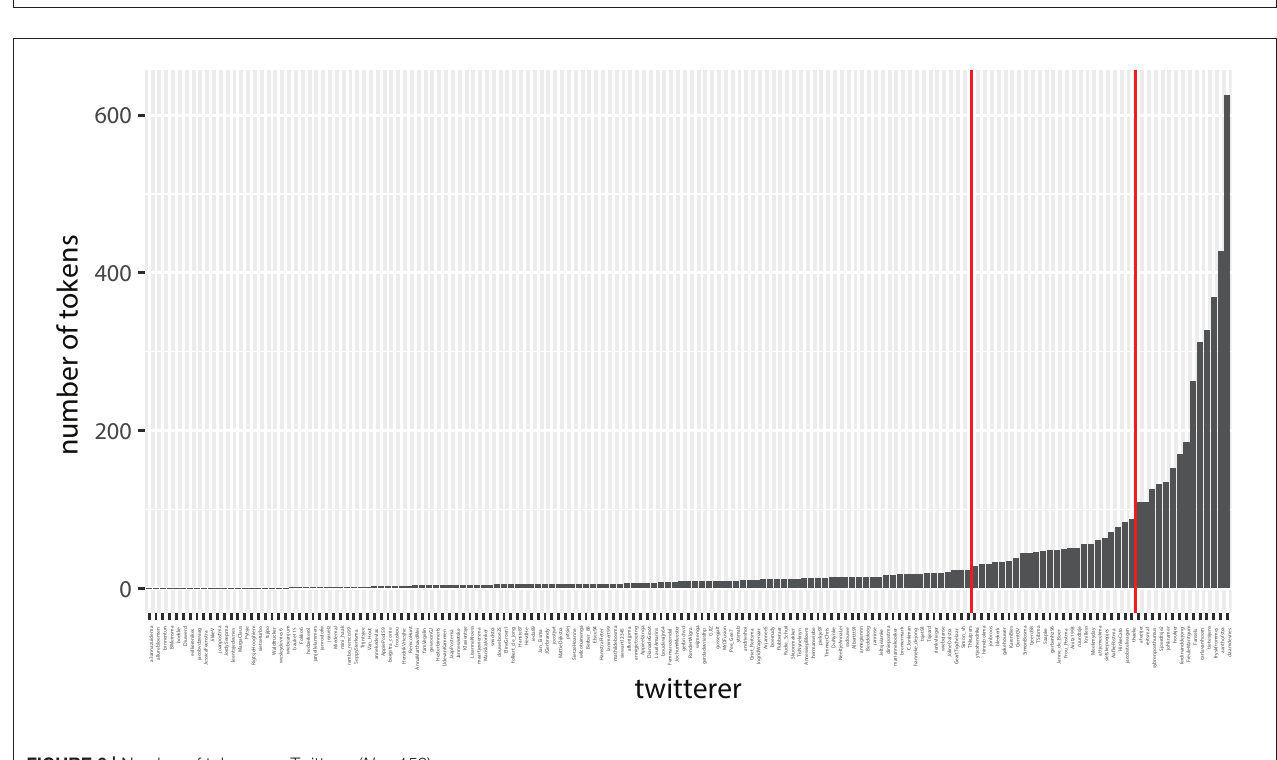
FIGURE 5 | Distribution of number of Twitterers per percentage of t-full forms used ( N = 159).